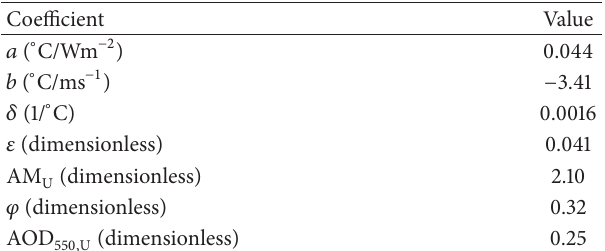
Table3:Valuesofthecoefficientsobtainedfromoutdoormonitored data for estimating the maximum power of the HCPV module